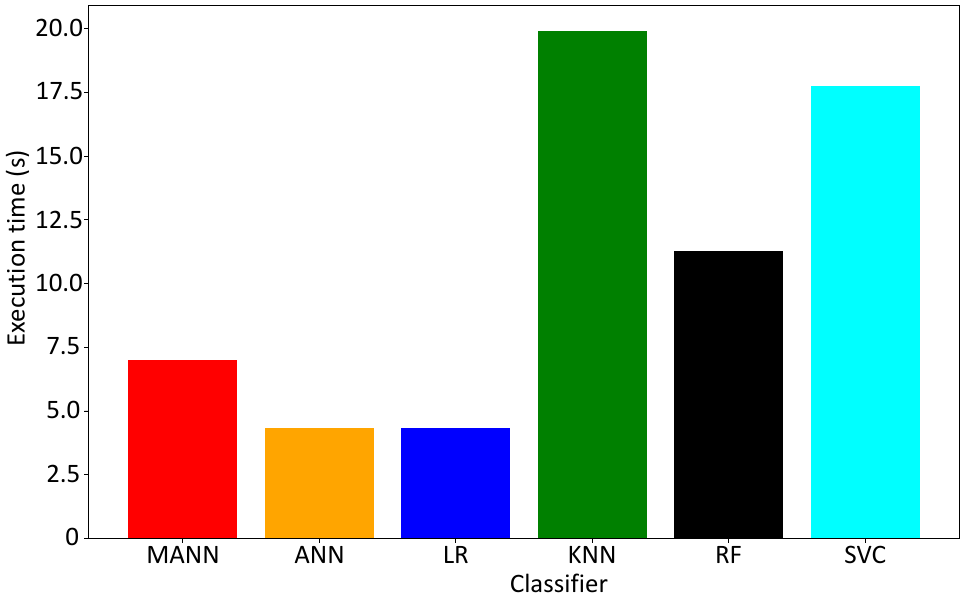
Figure 6. Comparison between classifiers’ training times. The usage of a memory does not crucially slow down the proposed neural